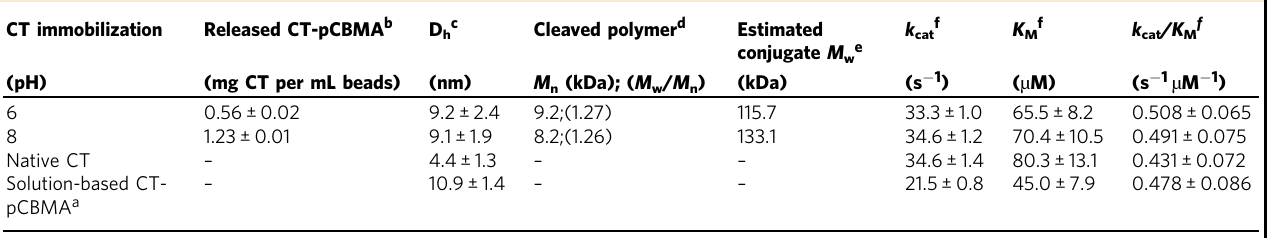
Table 2 Characterization of released PARIS-synthesized CT conjugates CT